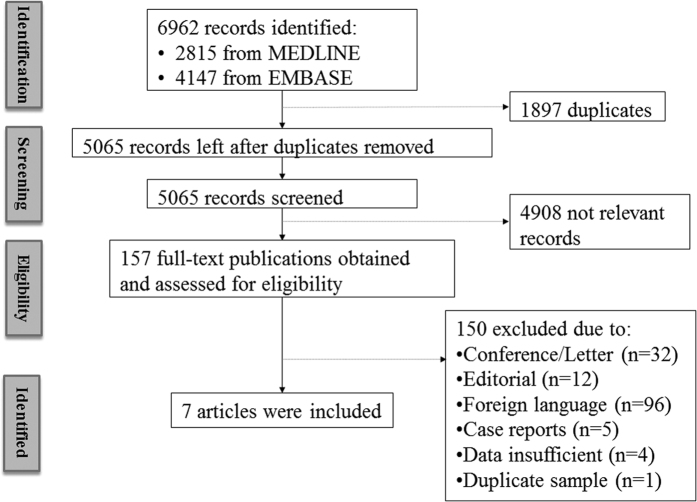
Flowchart of study inclusion.